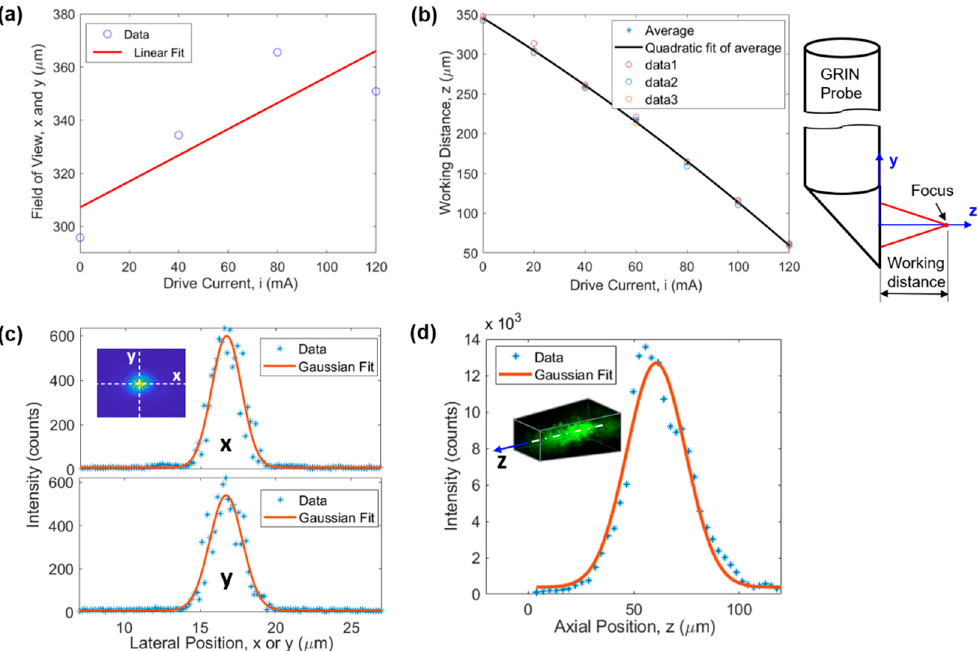
Figure 2. Characterization of the microimaging system. ( a ) FOV and ( b ) WD as a function of the drive current of the ETL, ( c ) lateral (i.e., x and y directions) and ( d ) axial (i.e., z direction) resolution.